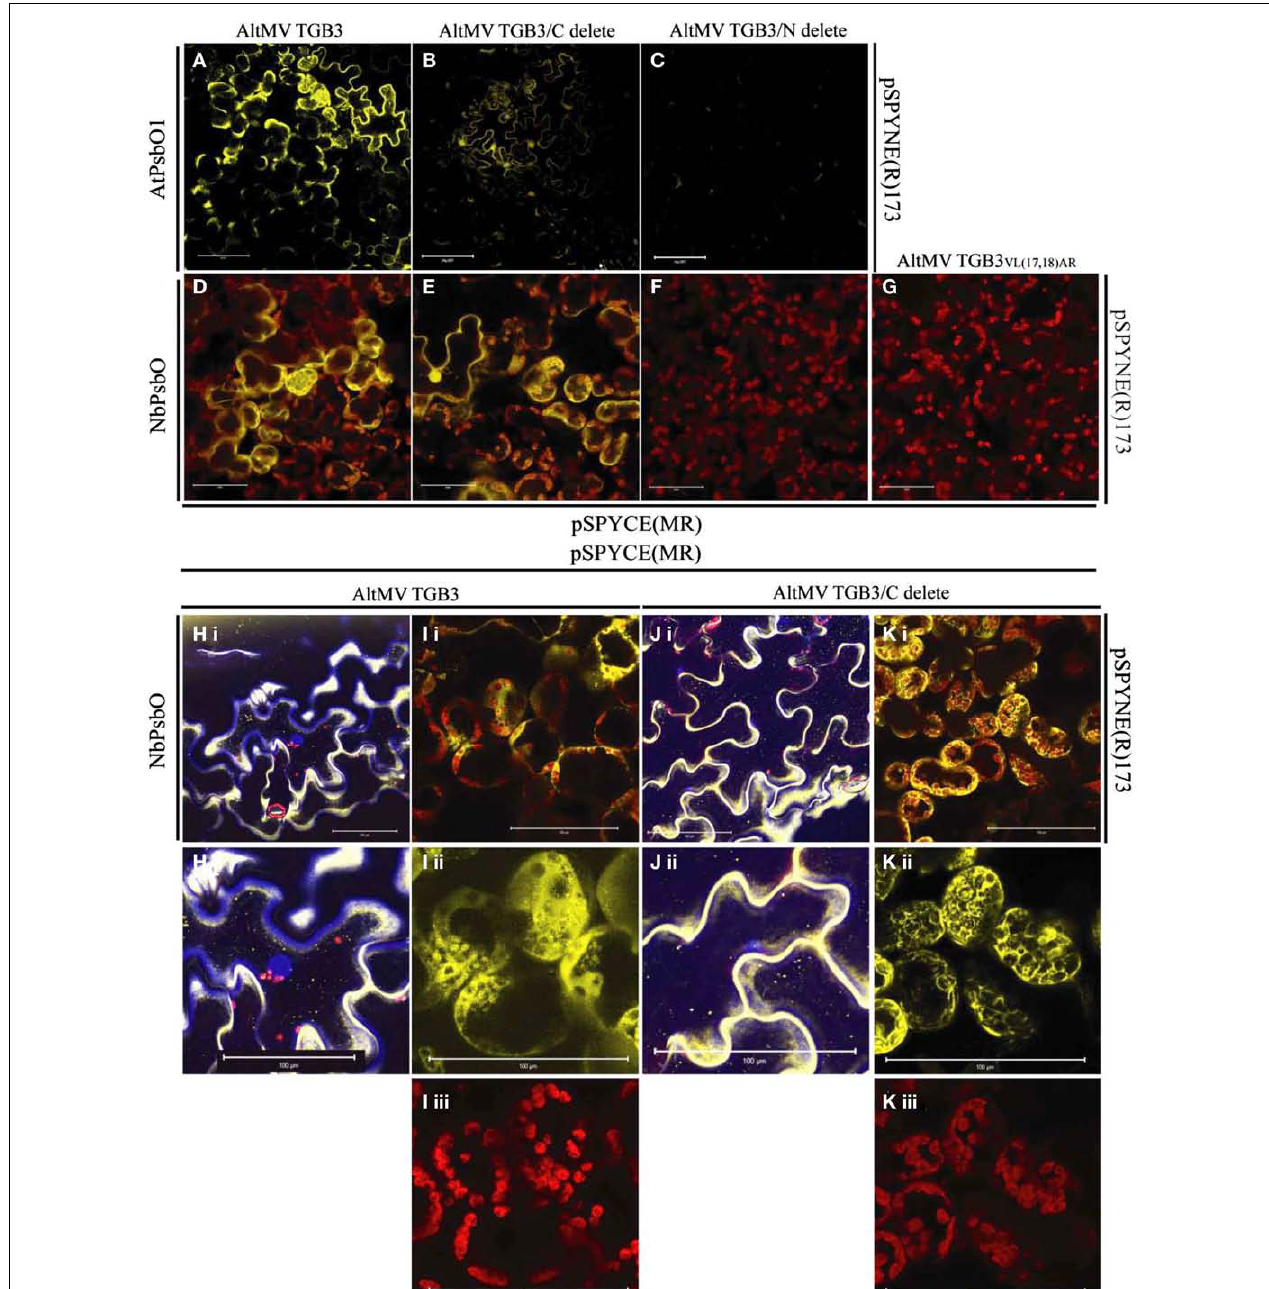
TGB3 in epidermal cells, with nuclei revealed by DAPI staining; and (ii) enlargement of lower left area of (i) , showing nucleus (blue) appressed to cell wall with absence of nuclear-associated BiFC interaction. (K) C-terminal deletedTGB3 in mesophyll cells, showing (i) BiFC interaction around chloroplasts; (ii) , BiFC (yellow) channel image of enlarged area of (i) , showing interaction at chloroplast envelope as well as in cytoplasm around chloroplasts; (iii) , Red channel (chloroplast autofluorescence) of same enlarged area as (ii) . Note BiFC reaction with full-length and C-terminal deletedTGB3, and absence of interaction with N-terminal deletedTGB3 or TGB3 VL(17,18)AR . AtPsbO1 and NbPsbO were fused with the N-terminal domain ofYFP in pSPYNE(R)173, whileTGB3 variants were fused to the C-terminal domain ofYFP in pSPYCE(MR). Red is chloroplast autofluorescence from mesophyll cells. Bars = 100 µ